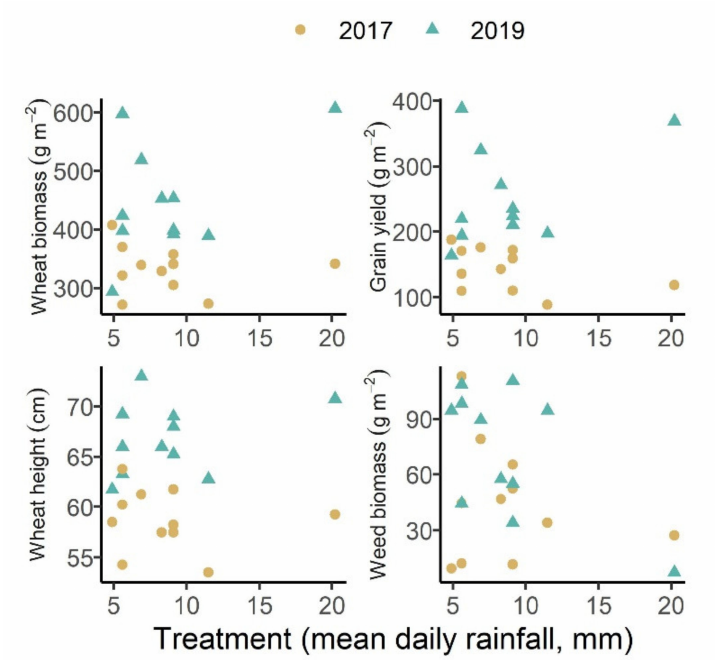
Figure 5. Aboveground wheat biomass, grain yield, wheat height, and aboveground weed biomass vs. mean daily rainfall (mean rainfall on days that received >0 mm rain; Table 1). Mean daily rainfall was not a significant predictor of the response variables shown